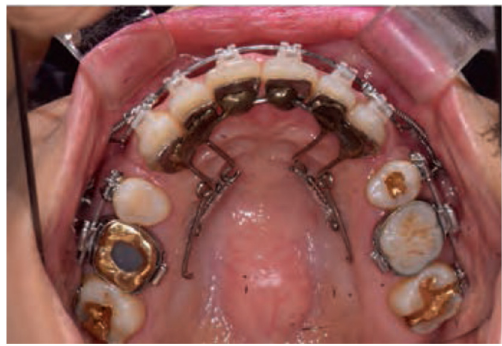
Figure 3. Double J retractor (DJR).